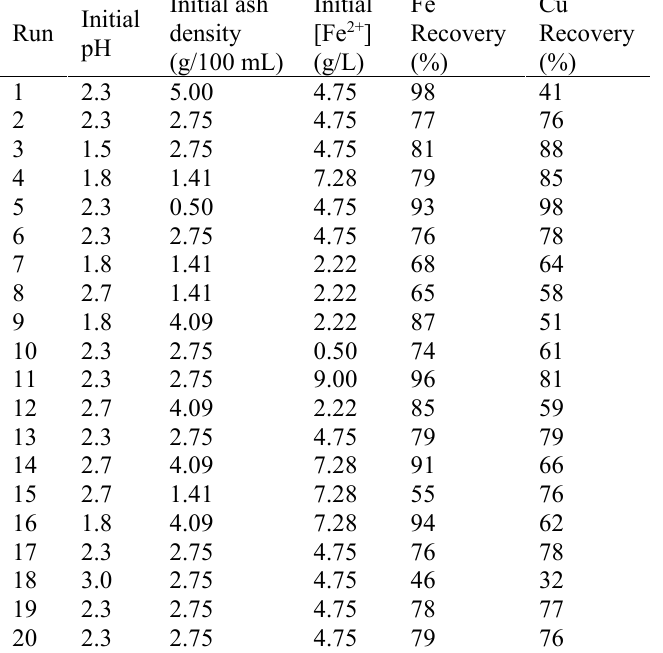
Table 3. CCD design and results